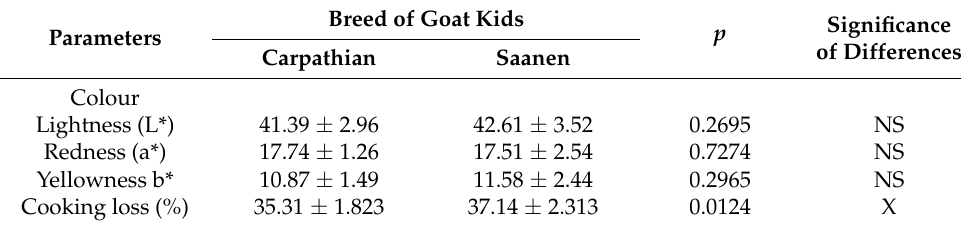
Table 3. Selected quality characteristics of the analysed meat